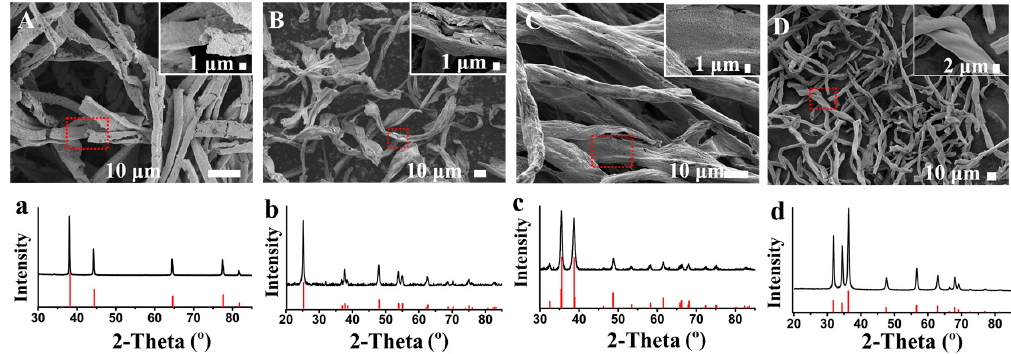
Figure 3. Various metallic materials fabricated from the template of medical absorbent cotton: ( A , a ) gold, ( B , b ) anatase, ( C , c ) cupric oxide, and ( D , d ) zinc oxide. ( A – D ) SEM images and ( a – d ) XRD patterns of the metallic materials. The red lines are PDF cards of ( a ) gold (PDF#04-0784), ( b ) anatase (PDF#21-1272), ( c ) tenorite (PDF#48-1548), and ( d ) zincite (PDF#36-1451).